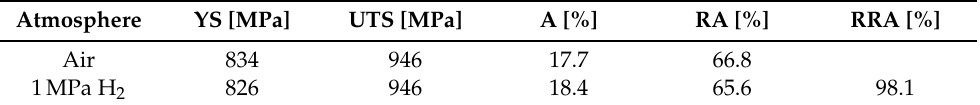
Table 1. Mechanical properties of the steel 1.4418 in QT900 condition. Given are yield strength (YS), ultimate tensile strength (UTS), elongation to fracture (A), reduction of area (RA) and relative reduction of area